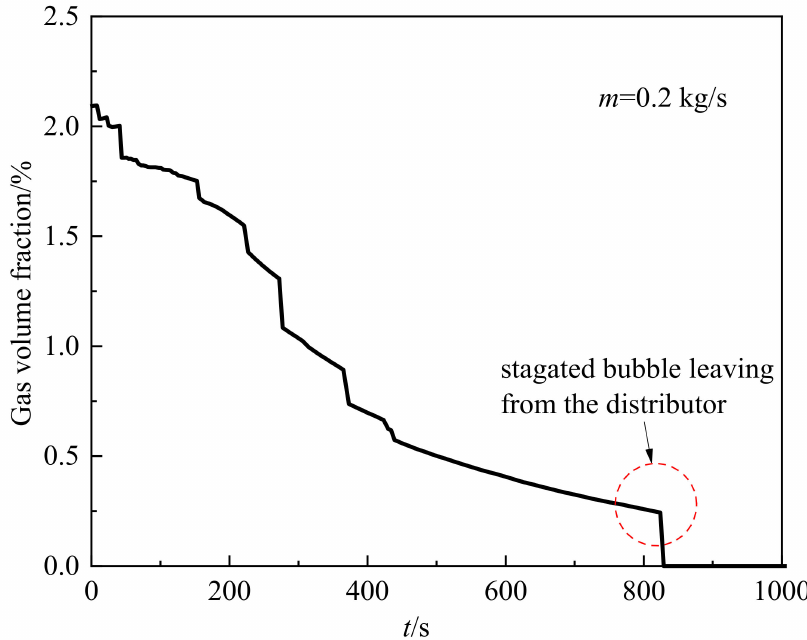
Figure 9. Evolution of gas fraction inside delivery tube under circulation precooling process with flow rate of m = 0.2